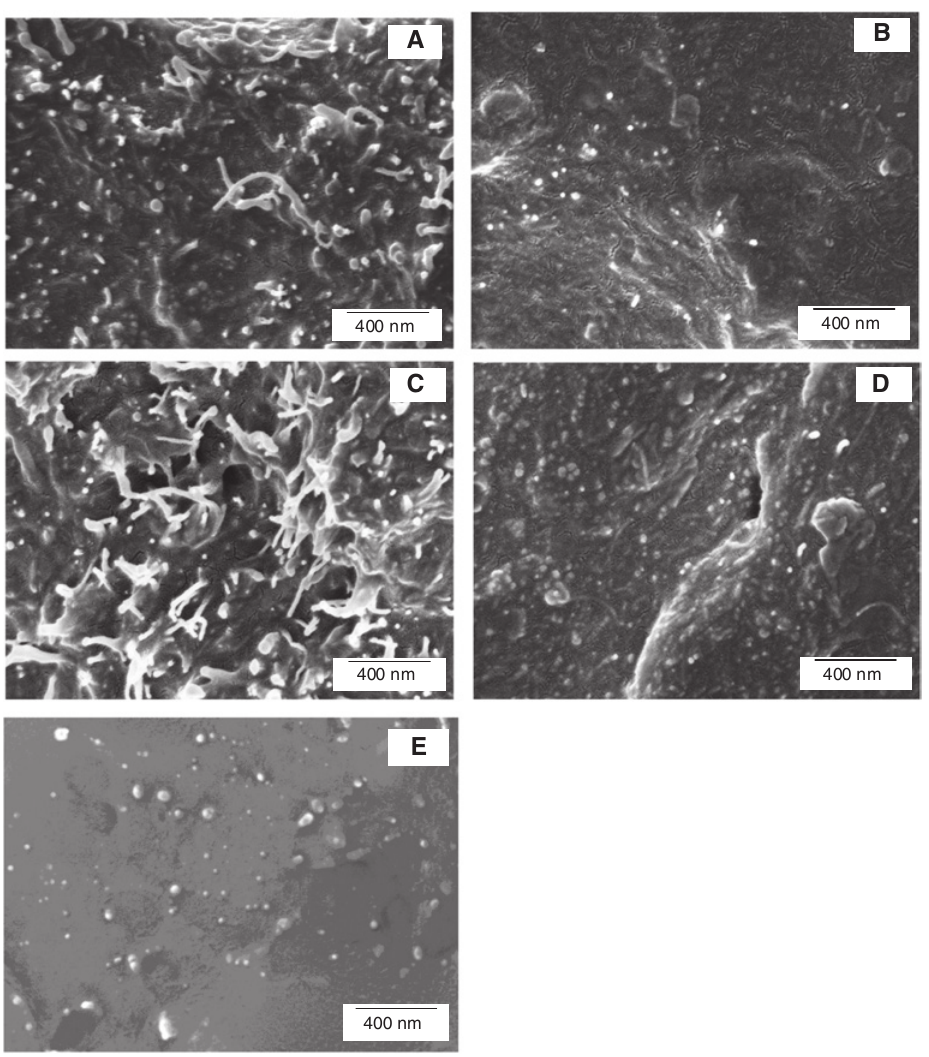
Figure 3 FE-SEM images of the cross section of TPNR containing 2 wt% (A) pristine MWCNTs, (B) acid-treated MWCNTs, (C) pristine